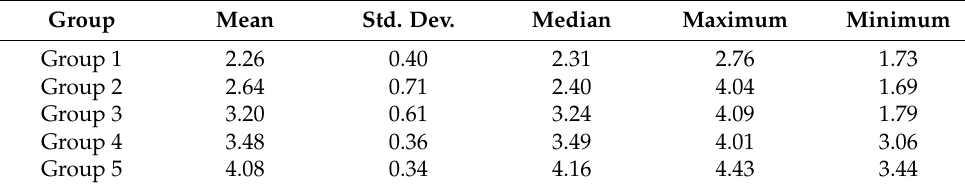
Table 3. Total emissions per household, in tCO 2 /year.